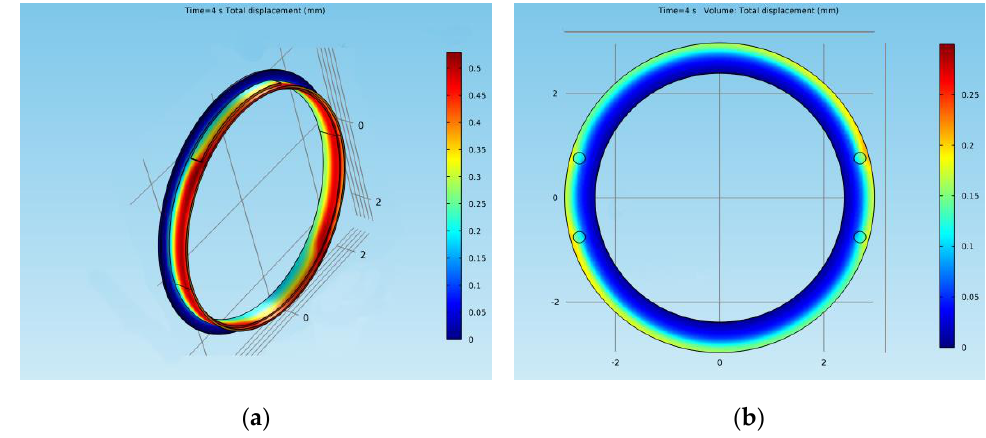
Figure 29. Global representation of deformation for: ( a ) drum-and-shoe couple; ( b ) disc-and-pads couple.